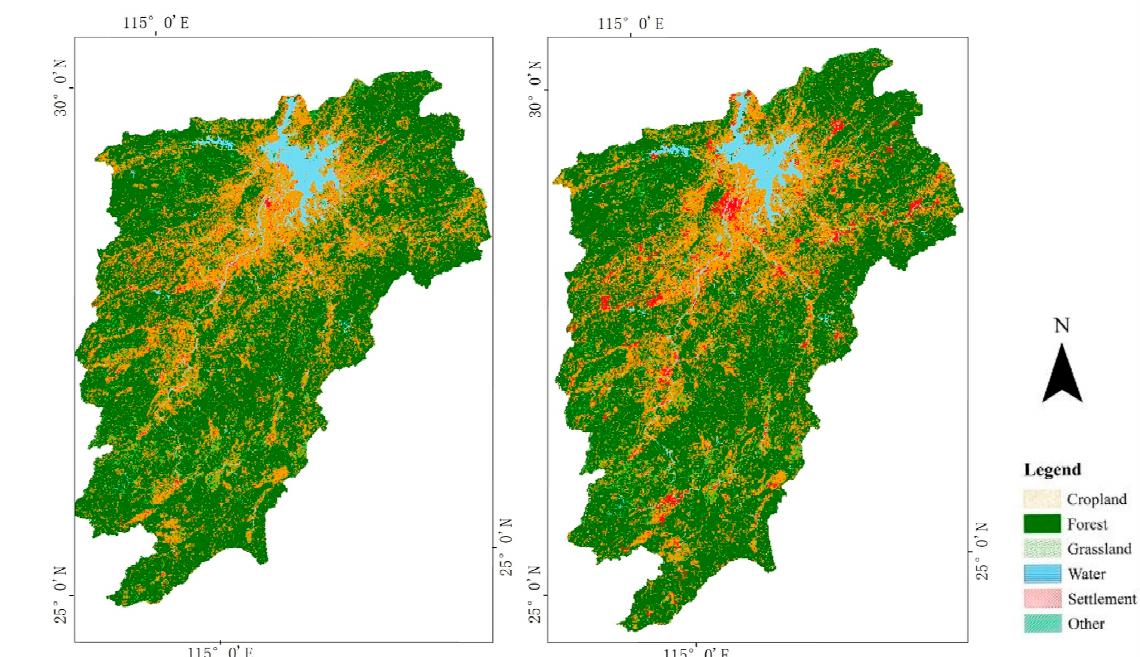
Figure 11. Comparison of land use of Poyang Lake basin from 1980 to 2020.